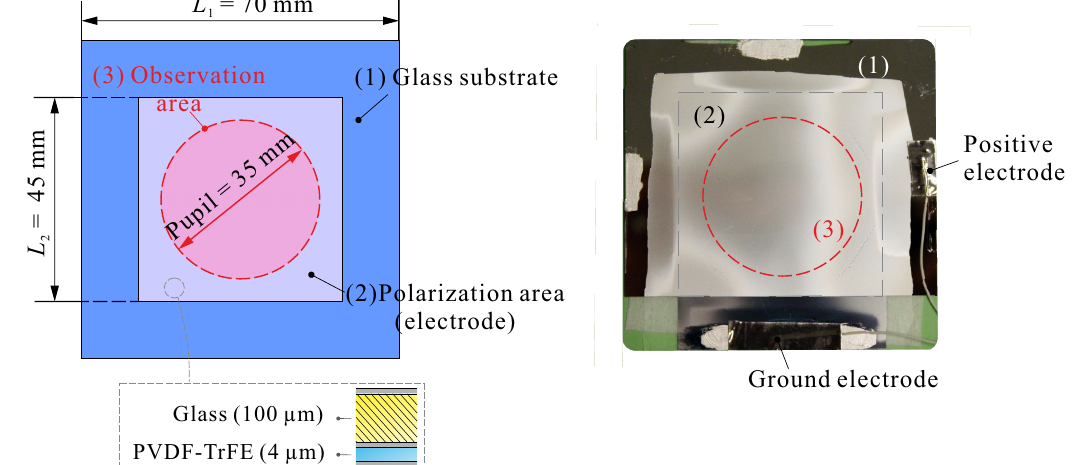
Figure 8. Glass sample used to estimate the poling strain of the PVDF-TrFE. The electrodes cover a square geometry in the center and the surface figure is monitored in a central circular pupil of 35 mm.